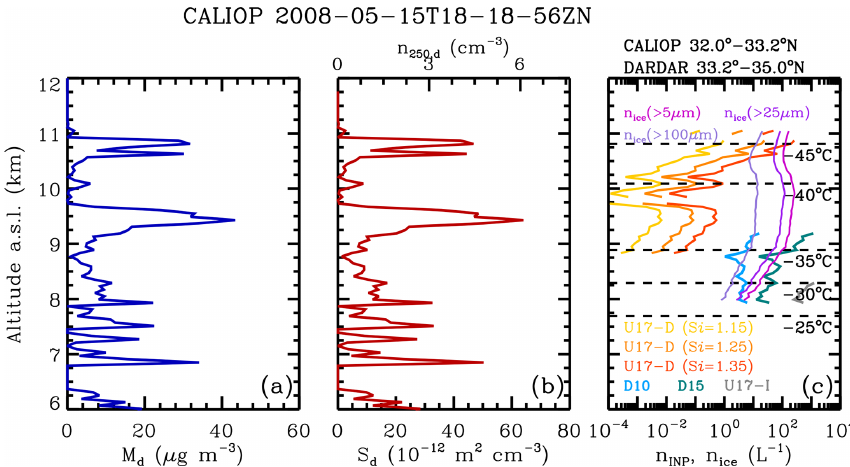
Figure 6. Profiles of the (a) dust mass concentration M d , (b) particle number concentration (with radius > 250nm) n 250 , d and surface area concentration S d , and (c) ice-nucleating particle concentration n INP (derived by the POLIPHON method using the parameterization schemes of D10, D15, U17-D, and U17-I) and ice crystal number concentration n ice (from DARDAR-Nice data product) on 15 May 2008. INP-related parameters are calculated from the dust-related optical properties given in Fig. 5 (corresponding to the CALIOP footprints between 32.0– 33.2 ◦ N). For the DARDAR-Nice product, the profiles within the latitude range of 33.2–35.0 ◦ N are integrated. S i denotes the ice saturation